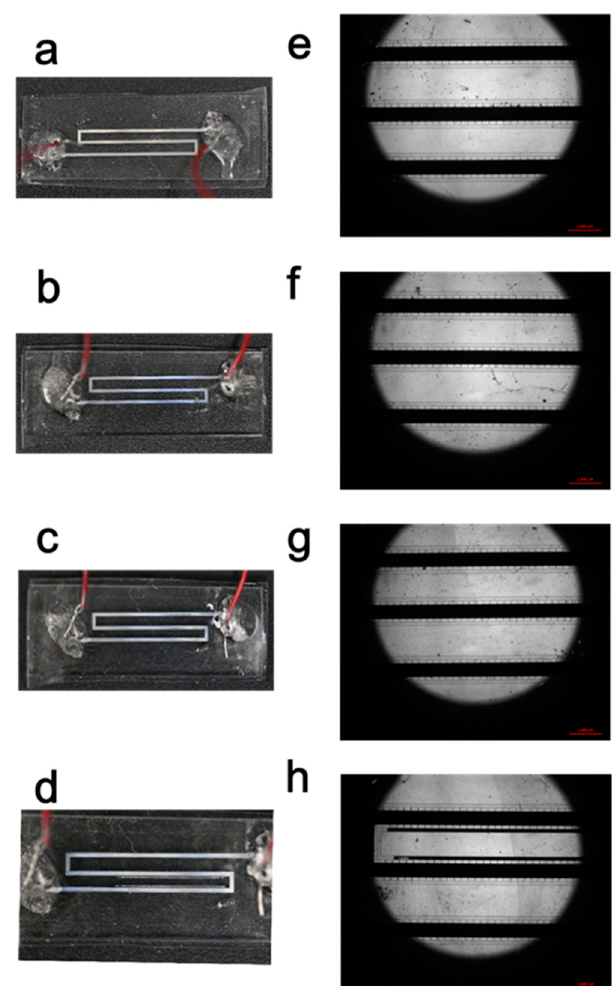
Figure 7. The morphology of 400 µ m-wide microeletrode with 20 µ m-gap posts after considerable bending cycles. ( a – d ) displays the state of the microelectrode, as carried out 0, 50, 100, 200 cycles; ( e – h ) representing the microscopic image respectively correspond to ( a – d ).